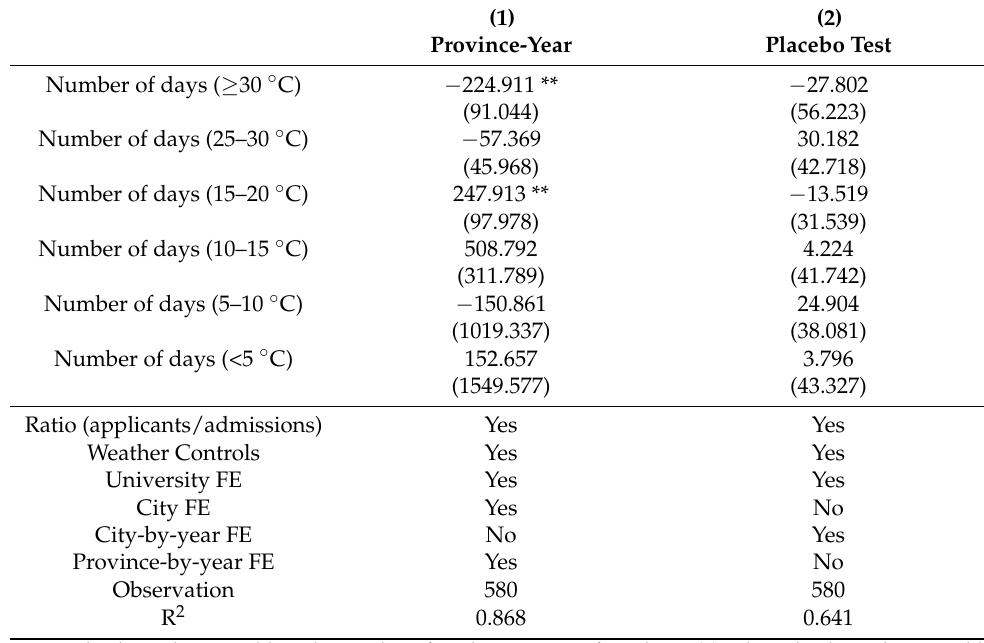
Table 4. Robustness checks: alternative